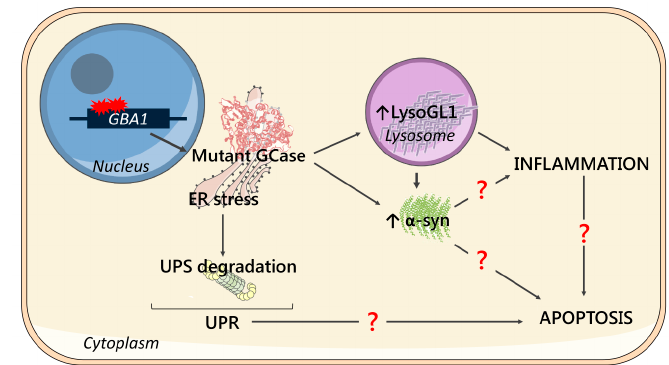
Figure 5. Schematic representation of the main cellular features and their possible correlation. Mutations in the GBA1 gene cause the synthesis of a mutant form of GCase, which is retained in the ER causing ER stress and subjected to degradation via the ubiquitin-proteasome system (UPS degradation), triggering unfolded protein response (UPR). The low enzymatic activity of the mutant GCase leads to LysoGL1 accumulation in lysosomes, which has been associated with neuroinflammation. Mutated GCase and substrate storage might lead to α -syn accumulation, which may have a direct role in the development of inflammation. Moreover, α -syn accumulation, UPR and/or inflammation may be the key triggers of apoptotic processes, eventually causing cell death. In conclusion, we obtained models of two cellular types relevant for GD pathology that recapitulate the main hallmarks of the disease, using CRISPR/Cas9 editing technology: THP-1 GBA1 mutant monocytes and U87 GBA1 mutant glial cells. These models will be useful tools to investigate GD pathophysiology and to identify novel potential treatments through high-throughput drug screenings.